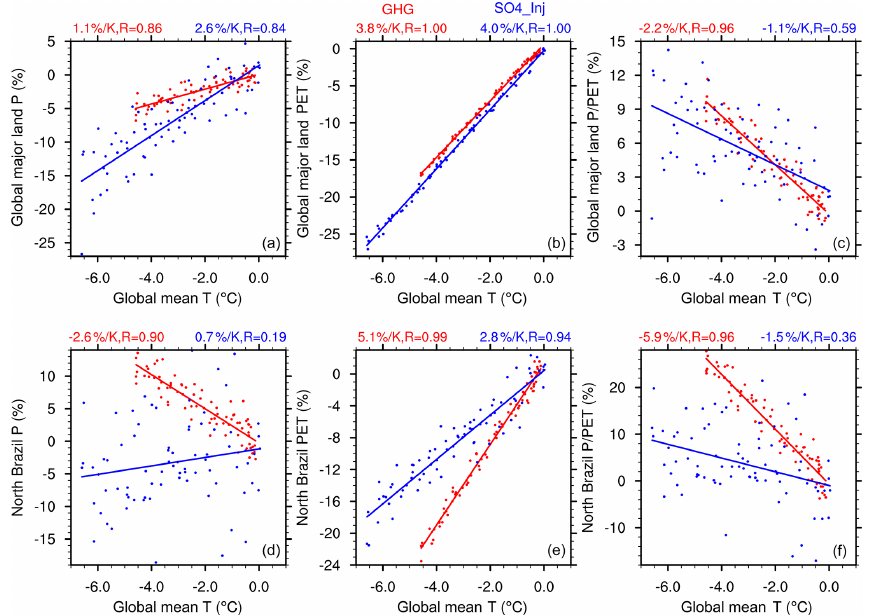
Figure 9. The changes in global major land P , PET, and P / PET as a function of global mean temperature change (ocean + land). Each dot represents a model year during 2020–2097. Red is for carbon capture (using CESM), and blue is for sulfur injection (using WACCM). (a, b, c) Global land; (d, e, f) northern